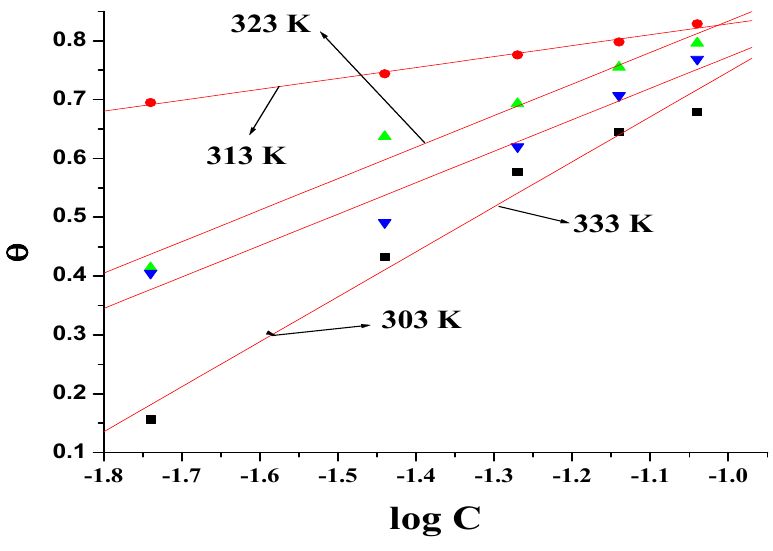
Figure 11. Temkin adsorption isotherm model. Table 5. Thermodynamic data for steel surfaces in the absence and presence of various concentrations of olmesartan in 1 mol dm − 3 HCl at temperatures ranging from 303 K to 333 K. Temperature